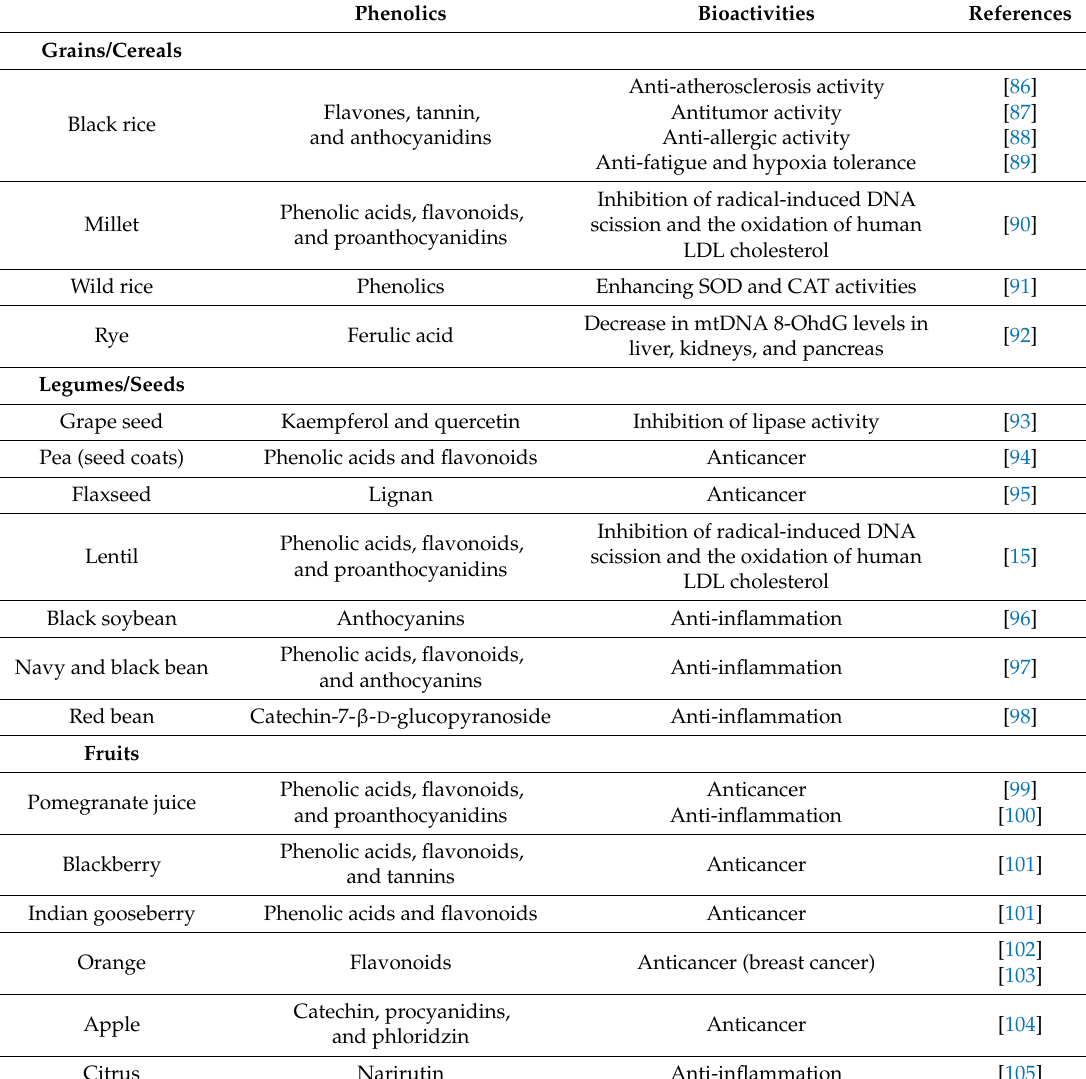
Table 2. Bioactivities of phenolic extract from natural origins. LDL: low density lipoprotein; SOD: superoxide dismutase; CAT: